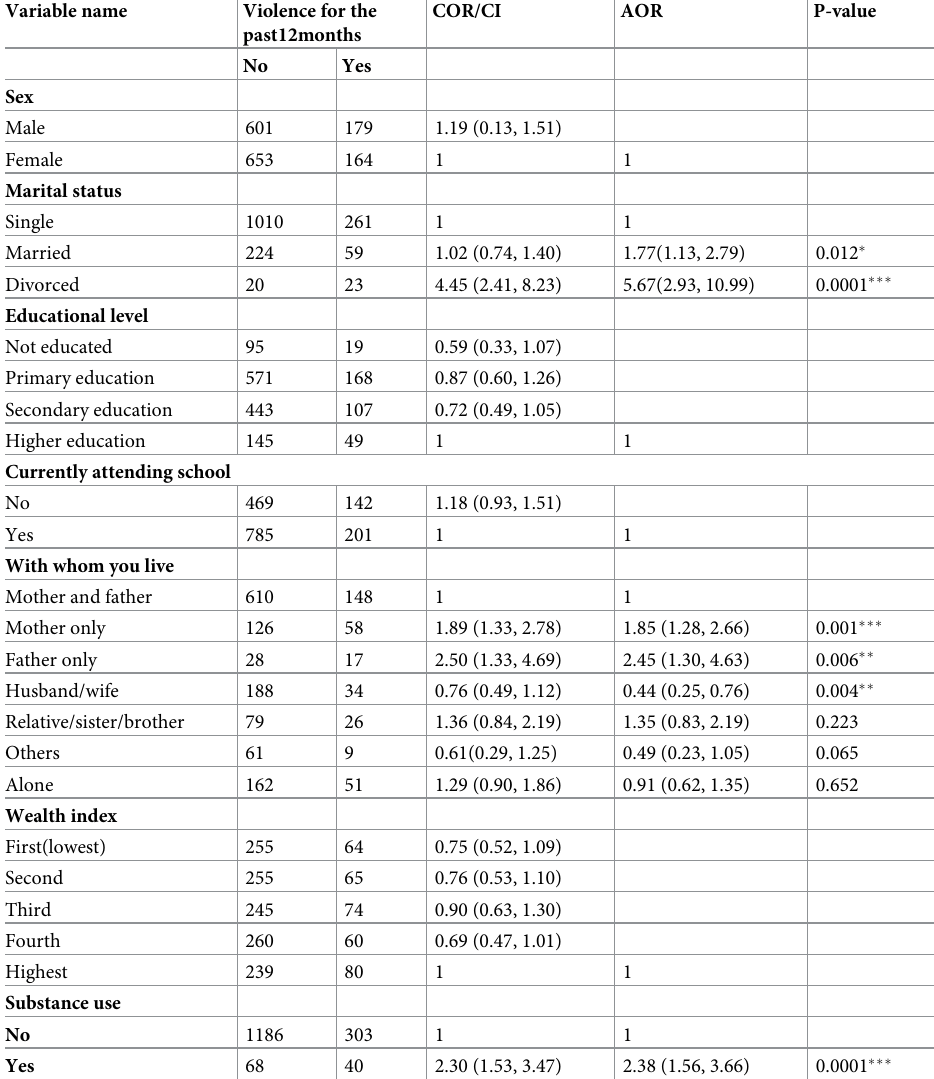
Table 3. Factors associated with violence among youth in Northwest,